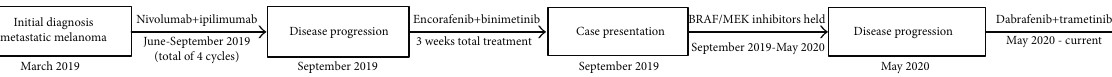
Figure 1: Visual timeline of treatment course leading up to symptoms present during case presentation.